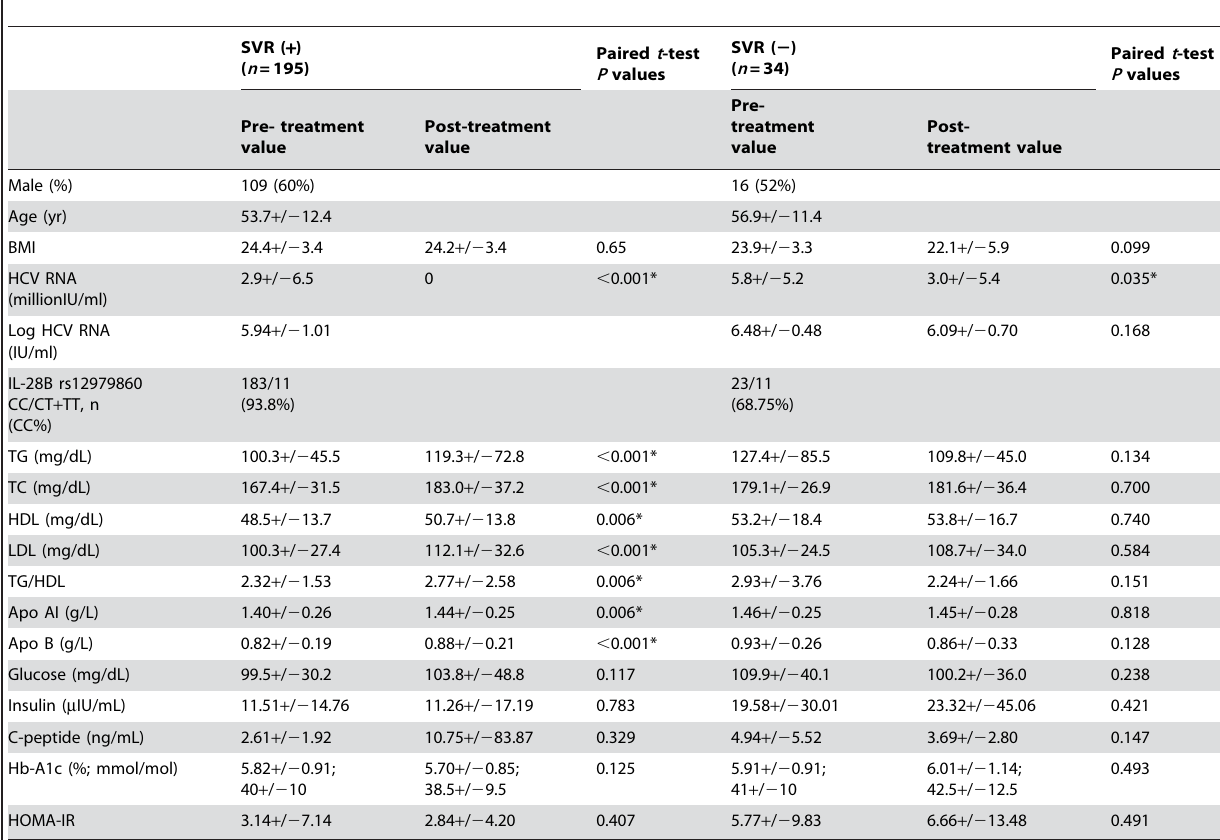
Table 2. Comparison of pre- and post-treatment variables in the CHC patients stratified by therapeutic